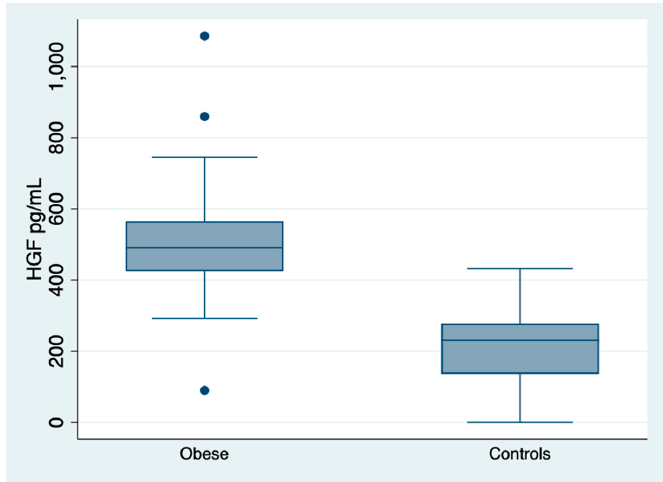
Figure 1. Growth factor concentrations in the obese and controls. Legend to Figure 1: HGF, hepatic growth factor. It is noteworthy to stress that the outliners were very few and that there is scarce overlapping between groups. Table 1. Main characteristics of the obese population.